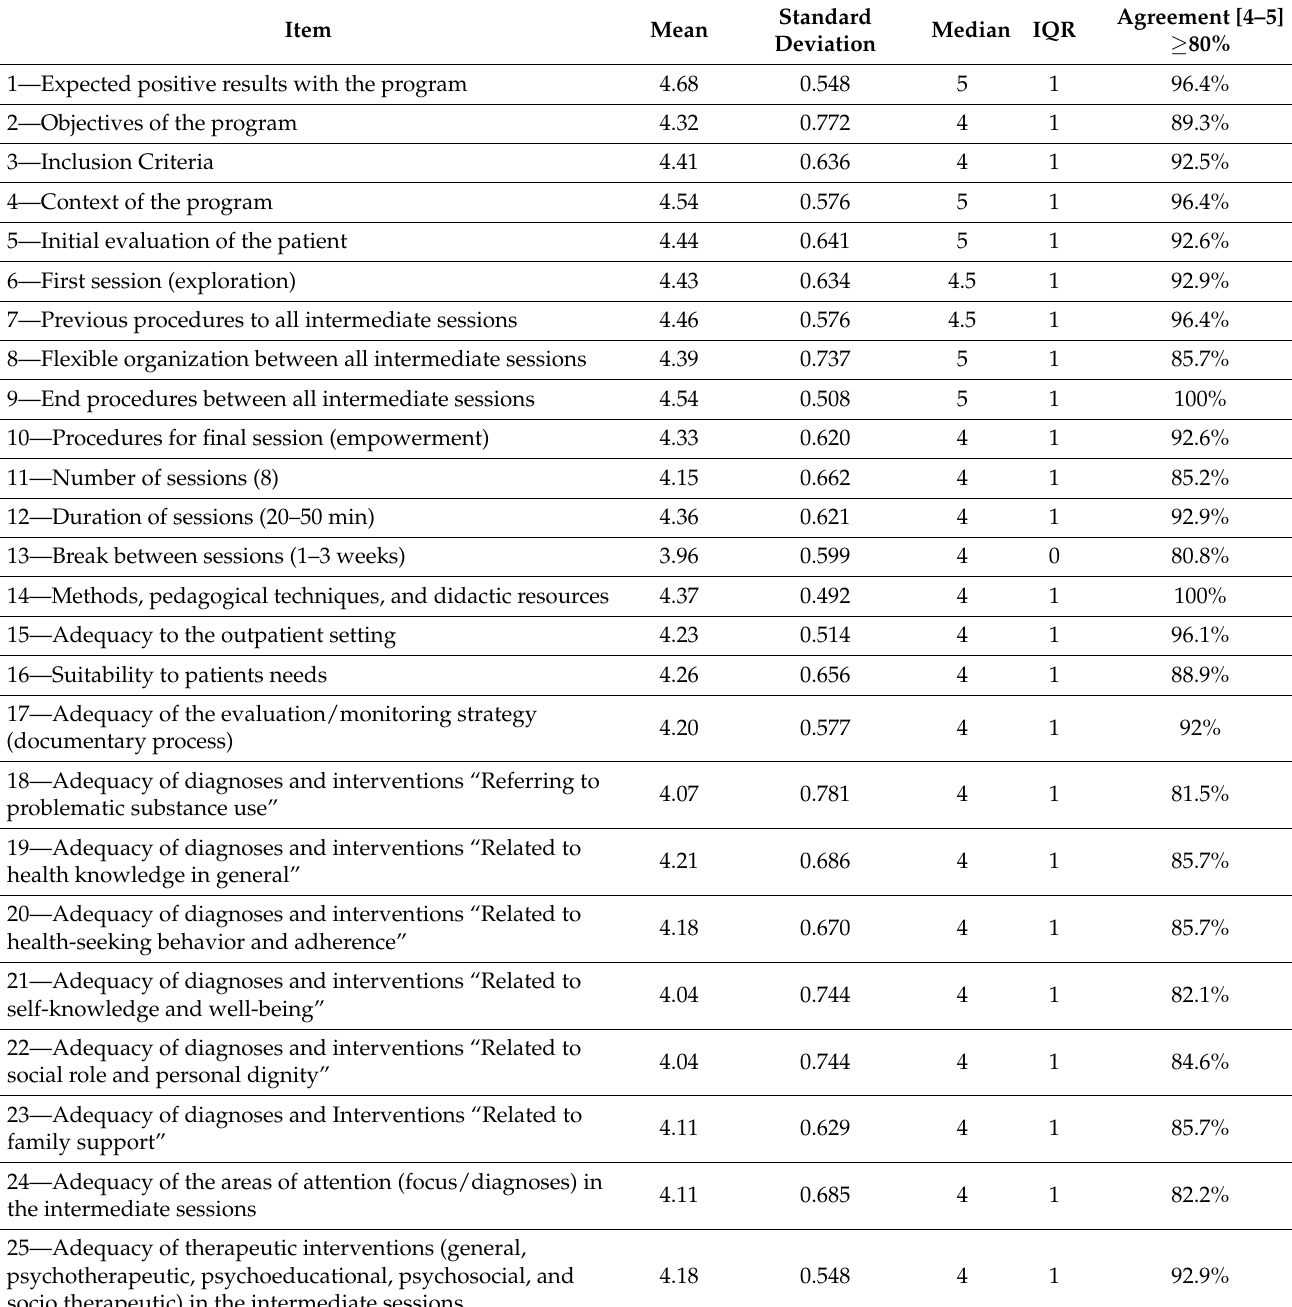
Table 1. Rate and consensus in first